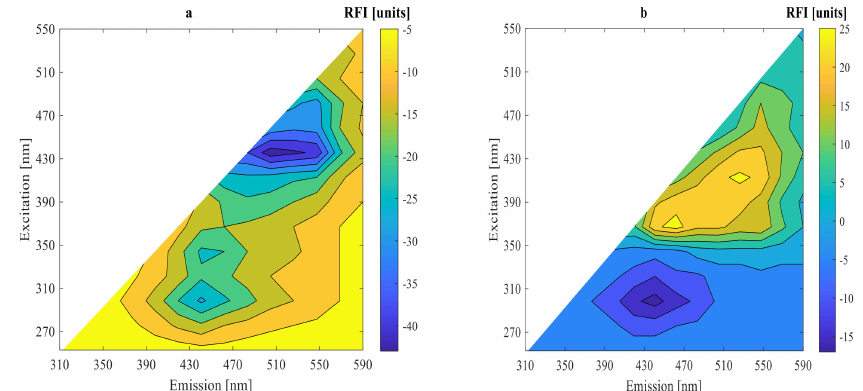
Figure 5. Subtracted spectra of the initial one from the original spectra after ( a ) 9 h and ( b ) 15 h fermentation of 7 g/100 mL substrate inoculated with 6 log cfu/mL mixed strains of Lactiplantibacil- lusplantarum A6 and Lacticaseibacillusrhamnosus GG.